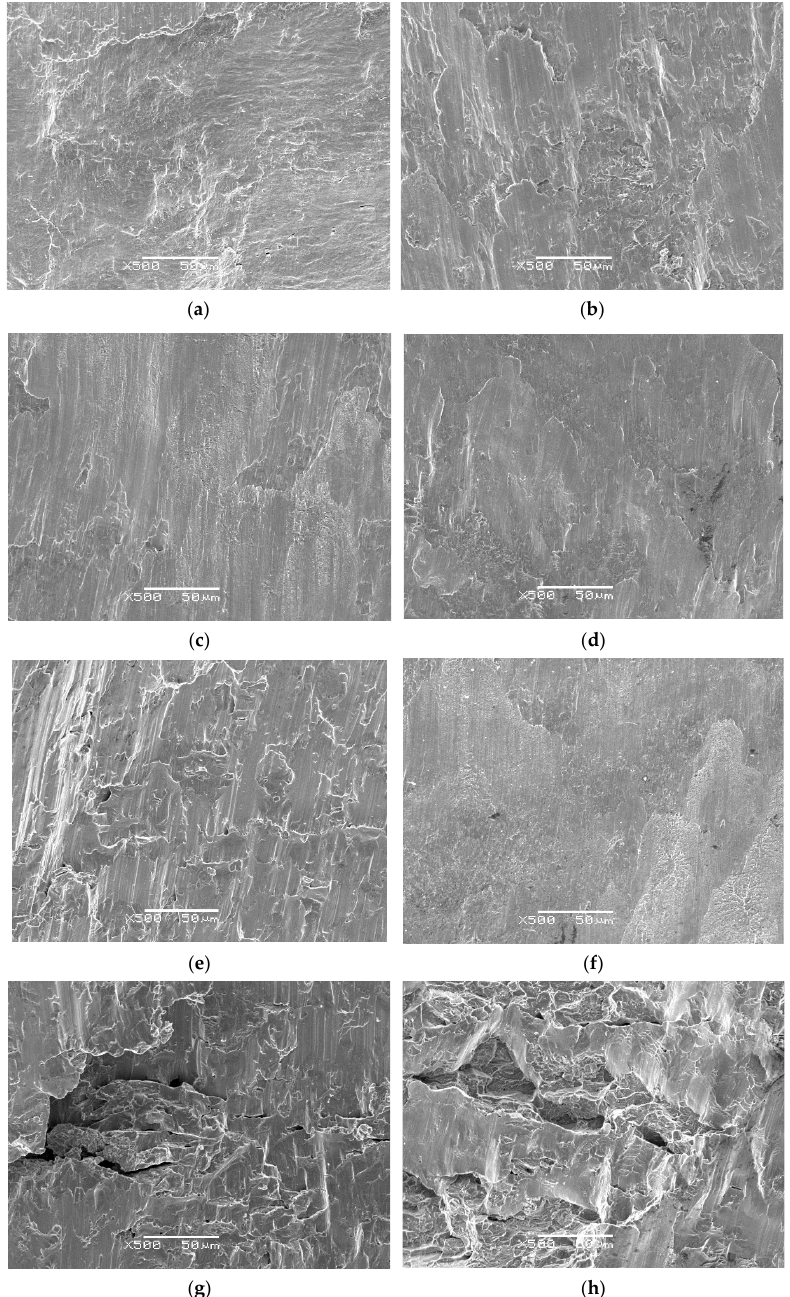
Figure 11. Fracture morphology of AlCoCrFeNiTi HEAs: ( a ) Ti-0.3; ( b ) Ti0.5; ( c ) Al-0.3; ( d ) Co-1.5; ( e ) Co-2; ( f ) Fe-2; ( g ) Ni-1.5; and ( h ) Ni-2.